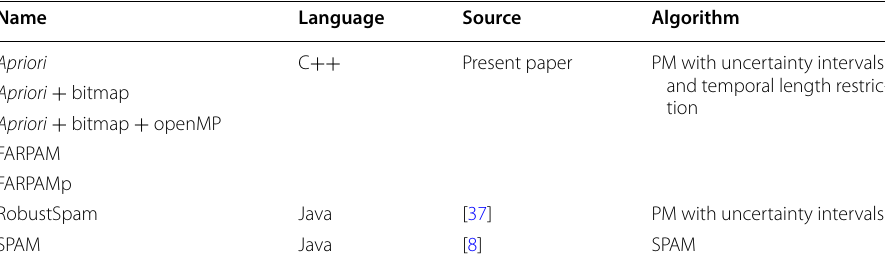
Table 1 Algorithms tested in the paper